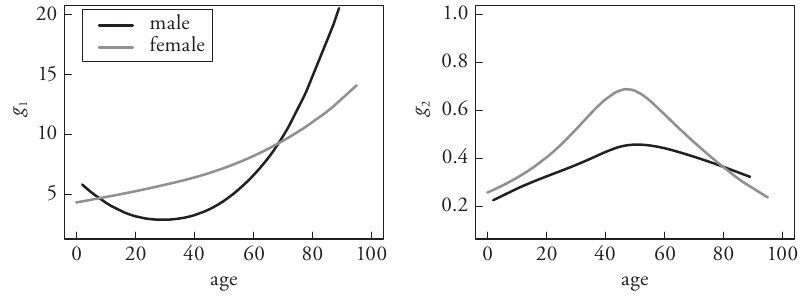
Figure 7: Impact of age and gender on the GAMLSS nonparametric regression